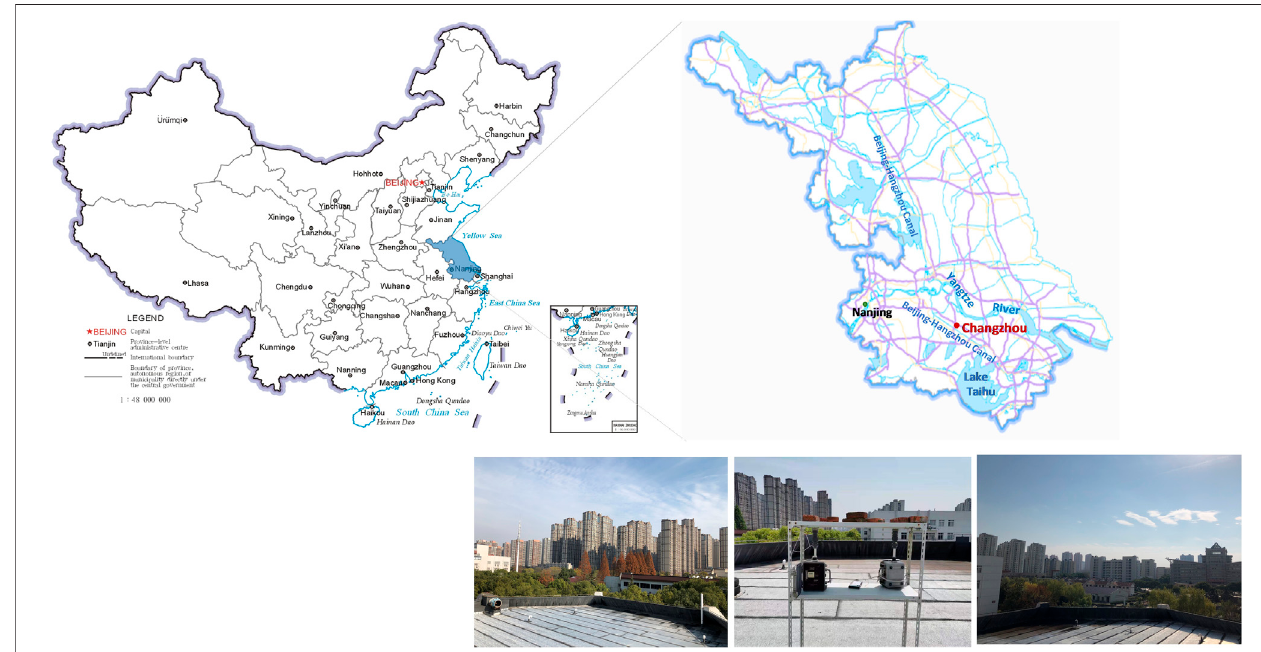
FIGURE 1 | Map of Jiangsu province ( fi lled with blue in the left panel) and Changzhou (red dot in the red panel). The observation site photos were displayed in the bottom right panel. (Maps downloaded from the website http://bzdt.ch.mnr.gov.cn/index.html.).